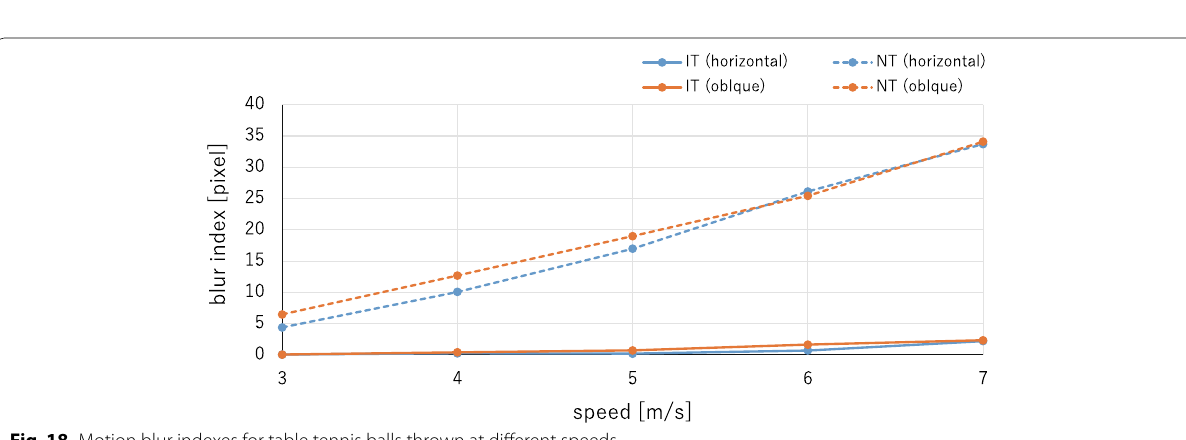
Fig. 18 Motion blur indexes for table tennis balls thrown at different